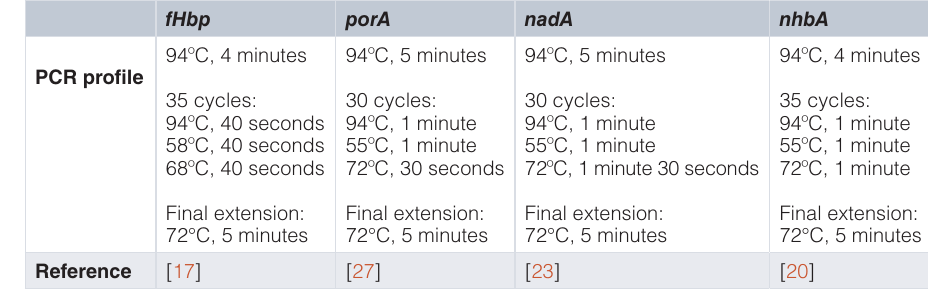
Table 3. Conditions used for PCR amplification of the genes fHbp , porA , nadA and nhbA